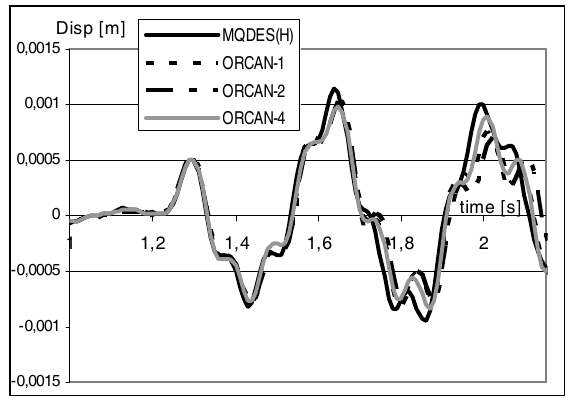
Fig 7 . Displacements diagram of the top of the segment in